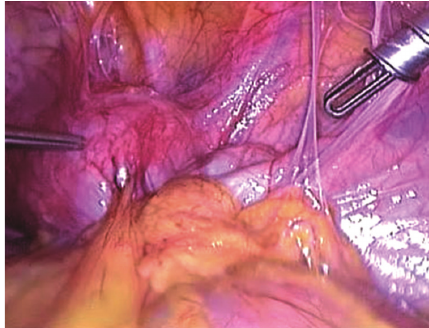
Figure 1: Laparoscopic vision of the completely separated and distanced right horn, with no communication with the unicornuate uterus, without any Fallopian tube or ovary, and with a small myoma belonging to it.